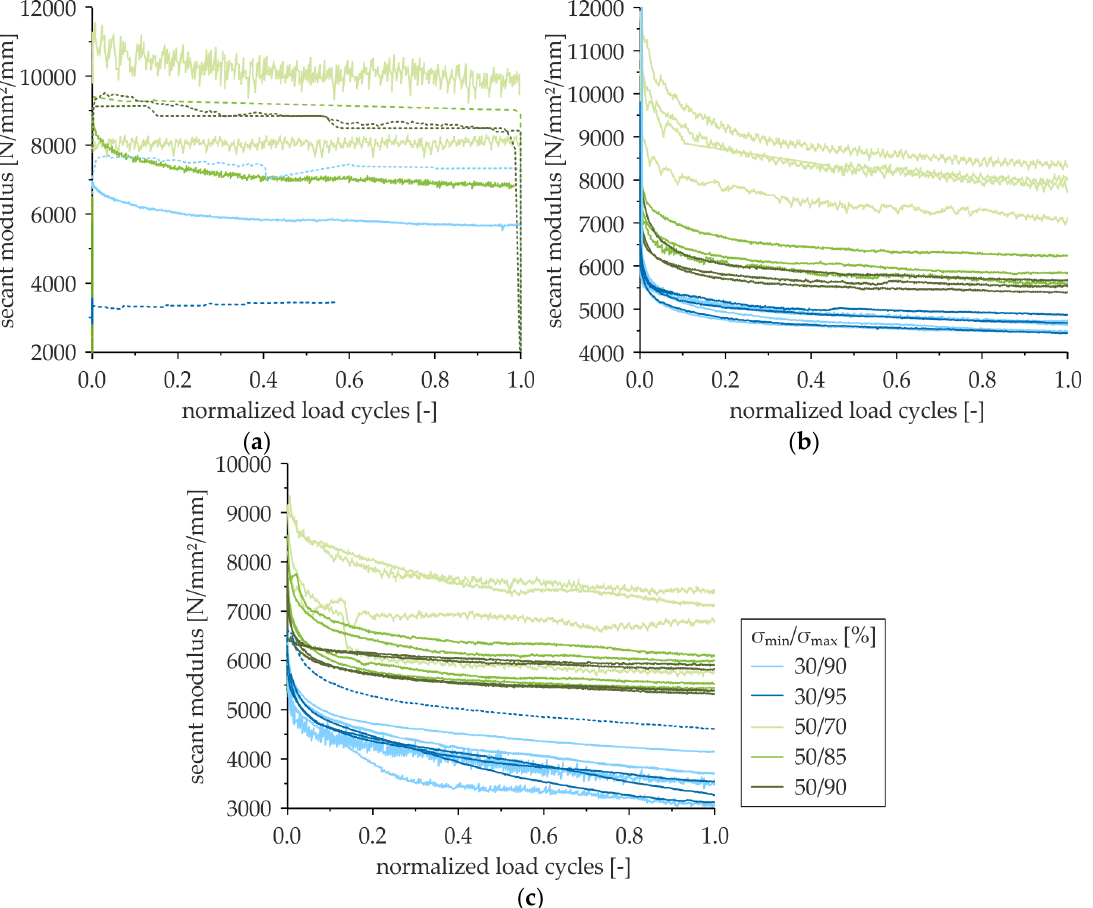
Figure A6. Comparison of the normalized development of the secant modulus depending on the load level: ( a ) anchorage length = 1 a ; ( b ) anchorage length = 2 a ; and ( c ) anchorage length = 4 a .